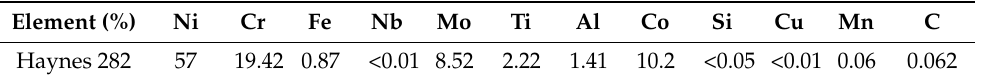
Table 1. Chemical composition of Haynes 282 alloy.